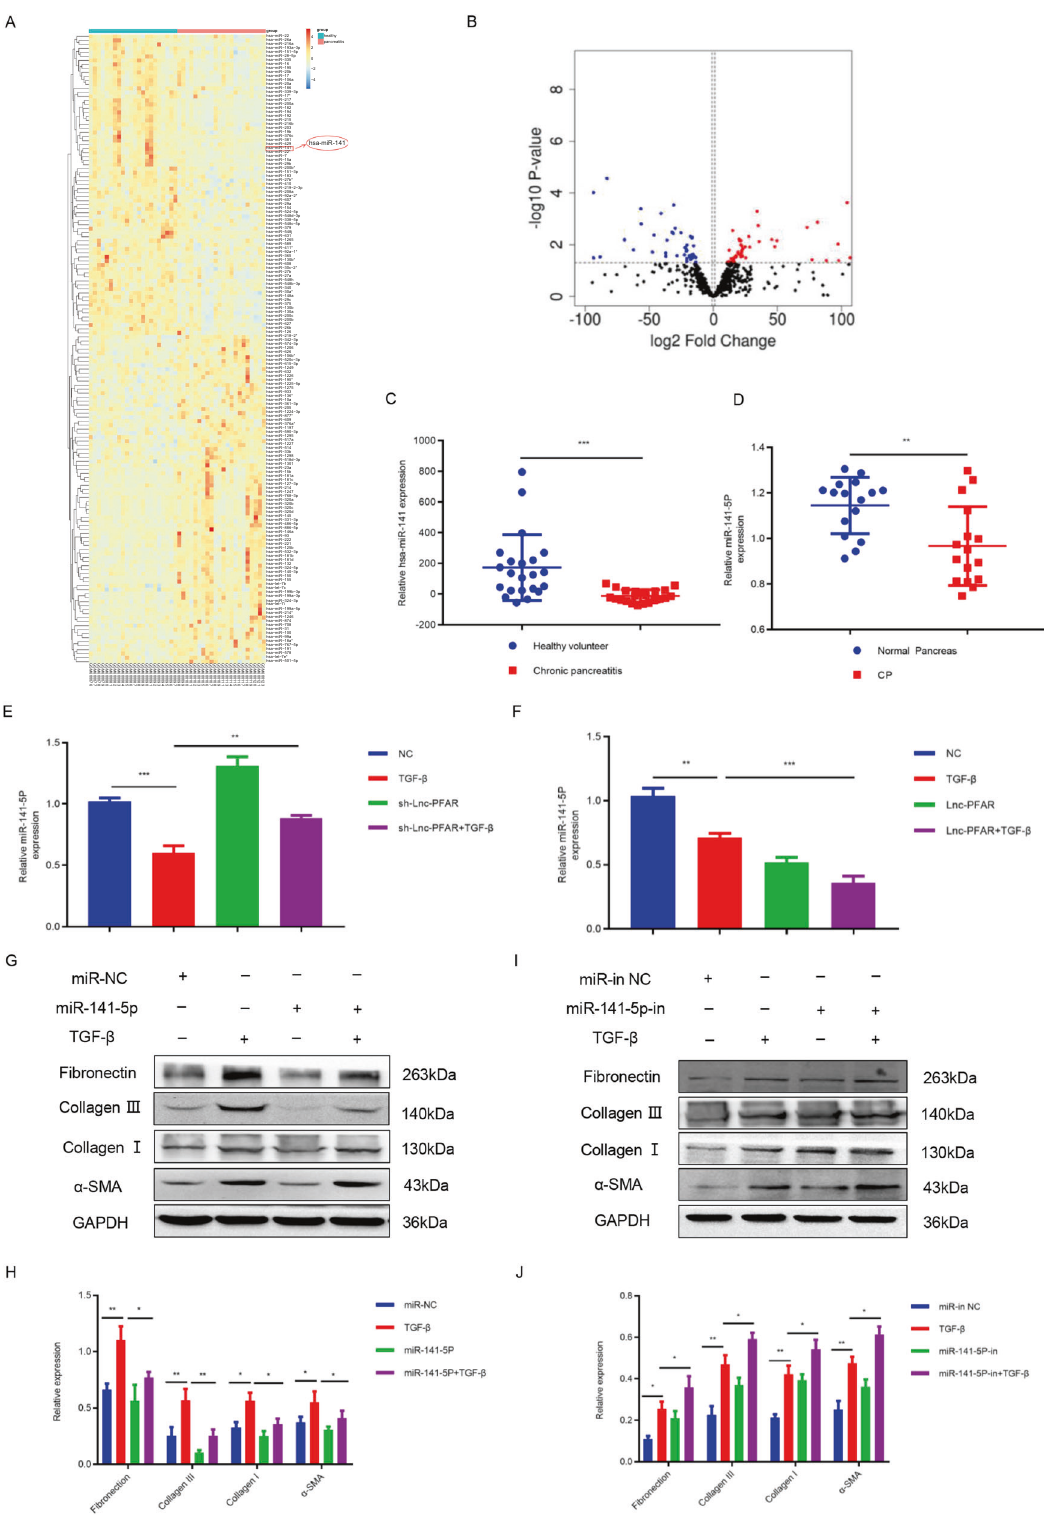
Fig. 2 Lnc-PFAR inhibited miR-141-5p to promote PSCs activation. A , B The differentially expressed miRNAs in normal pancreas and CP tissues were identi fi ed from the GEO dataset (GSE24279). C The relative expression levels of miR-141 in normal pancreas and CP tissues in GSE24279. D The expression levels of miR-141 in 16 pairs of normal pancreas and CP tissues. E , F The expression levels of miR-141-5P were explored in PSCs of quiescent, TGF- β -treated, sh-Lnc-PFAR, sh-lnc-PFAR plus TGF- β , Lnc-PFAR, and Lnc-PFAR plus TGF- β groups. G – J The expressions of α -SMA, Collagen I, Collagen III, and Fibronectin were examined in PSCs of quiescent, TGF- β -treated, miR-141-5P mimic-treated, miR-141-5P mimic-treated plus TGF- β groups, miR-141-5P inhibitor-treated and miR-141-5P inhibitor-treated plus TGF- β groups. The relative expression represents the ratio of target to GAPDH. The results are representative of three independent experiments (* p < 0.05 and ** p < 0.01). Cell Death and Disease (2021)